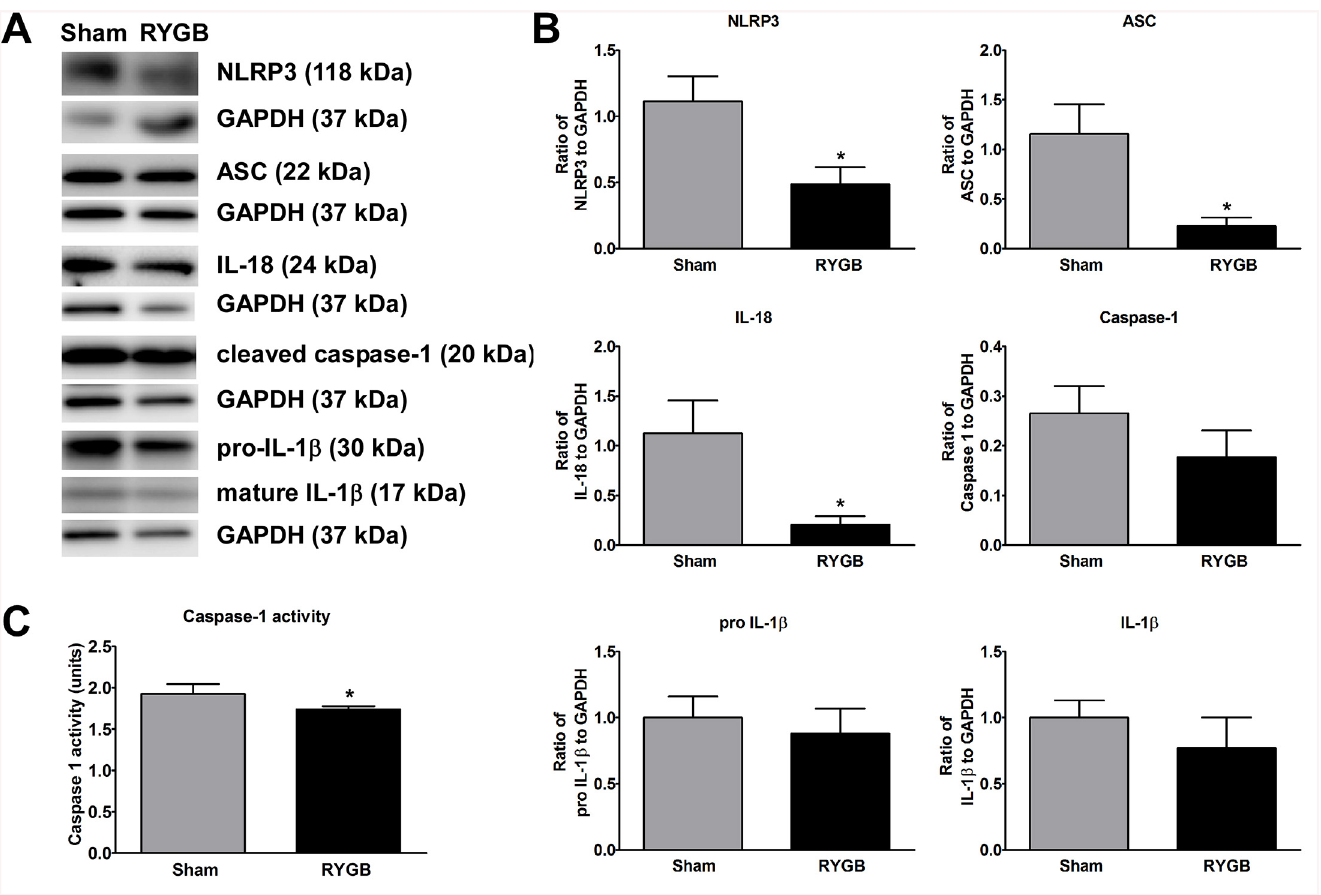
Fig 5. Differential protein expression of NLRP3 inflammasome components in omental adipose tissue. (A) Western blotting representative Western blot images showing NLRP3, ASC, IL – 18, cleaved caspase – 1, pro-IL – 1 β and mature IL – 1 β protein levels (upper) compared with GAPDH loading control (lower). (B) Differential expression of NLRP3, ASC, IL – 18, caspase – 1, pro-IL – 1 β and IL- β , control and RYGB in omental adipose tissue. Tissue homogenates were prepared as described in the Methods section; protein was separated by SDS-PAGE and probed with the appropriate antibodies. GAPDH was used as an internal loading control. Intensity of the band was quantified using ImageQuant TL software and expressed as the relative ratio to loading control. (C) Caspase – 1 activity was measured according to manufacturer's protocol in Sham control vs RYGB. Data are mean ± SE. * denotes a significant difference between Sham control vs.